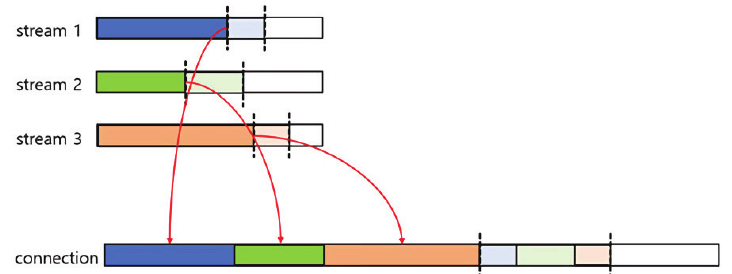
Figure 4. Connection-level flow control.